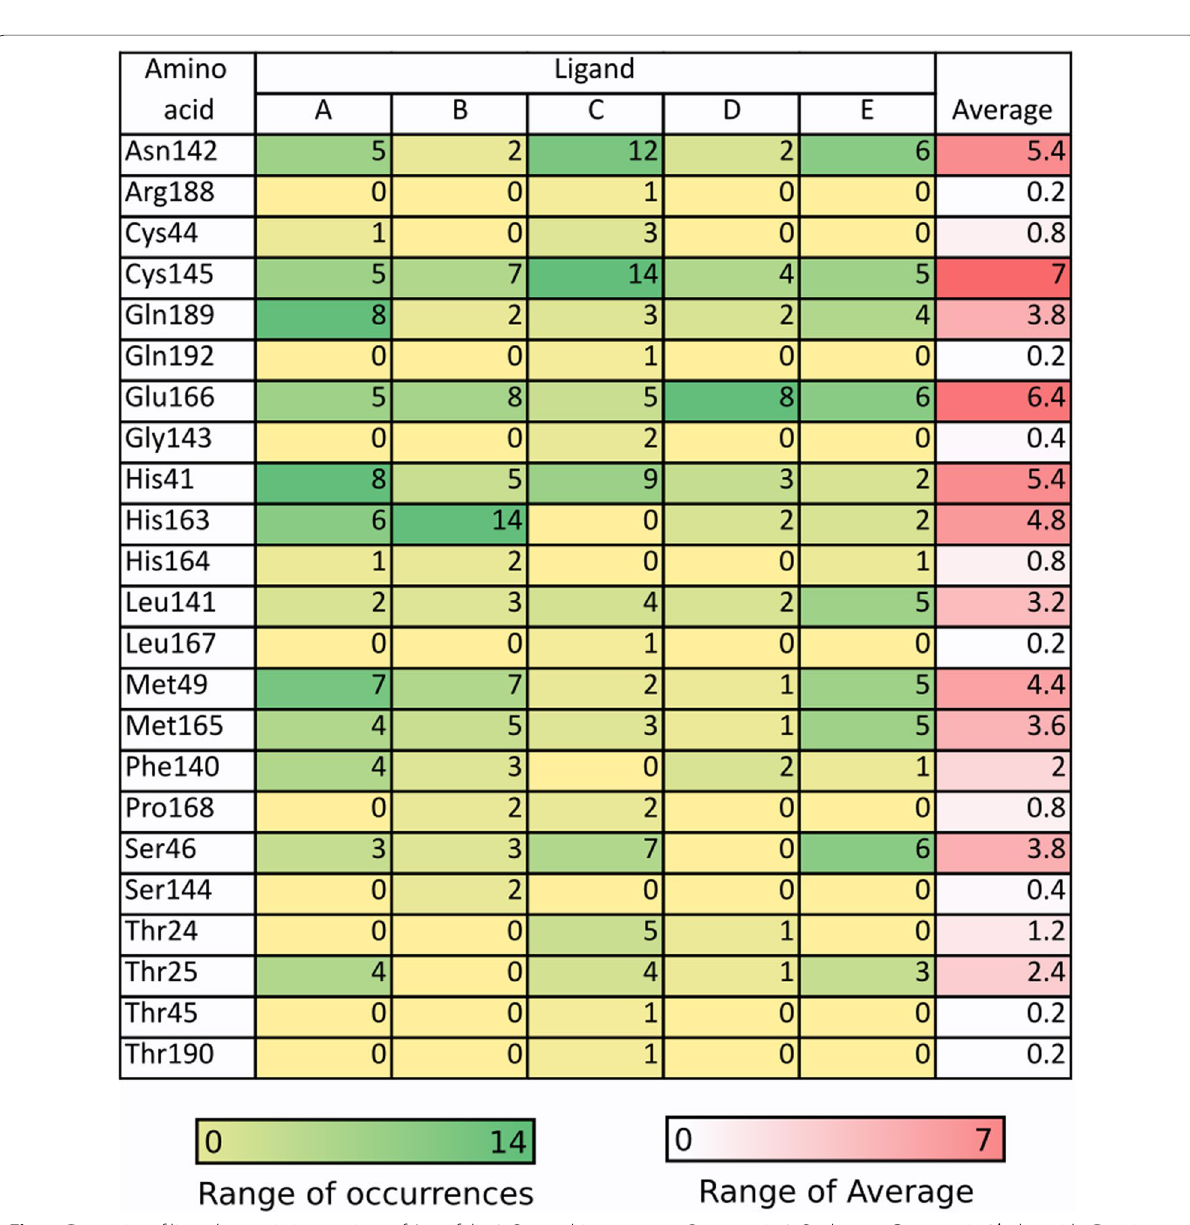
Fig. 4 Dynamics of ligand–protein interactions of A taxifolin 3-O-α-arabinopyranose, B quercetin 3-O-glucose, C quercetin 3 ′ -glucoside, D rutin, and E resemdivir. Note : The value is based on the number of occurrences in each interaction mode. Double bonds count as